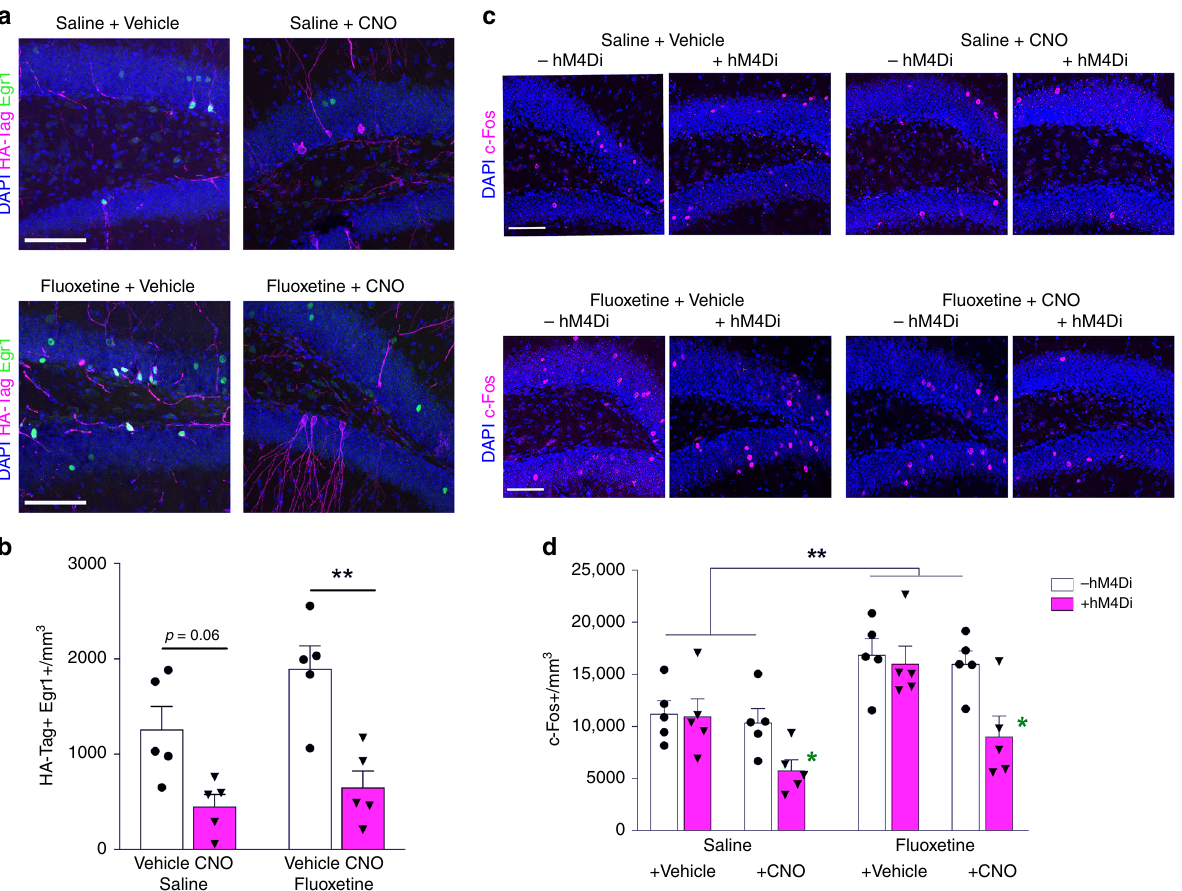
Fig. 3 CNO prevents the fl uoxetine-induced increase in activity of dentate gyrus neurons in vivo. a Representative images of HA-Tag + Egr1 + double- labeled dentate gyrus cells. b Quanti fi cation of HA-Tag + Egr1 + cells in the dentate gyrus (by two-way ANOVA: Fluoxetine F 1,16 = 4.288, P = 0.0549; CNO F 1,16 = 26.16, *** P = 0.0001; Interaction F 1,16 = 1.184, P = 0.293). c Representative images of c-Fos-positive dentate gyrus cells. d Quanti fi cation of c- Fos expression in the dentate gyrus. (by three-way ANOVA: Fluoxetine F 1,32 = 21.55, *** P < 0.0001; hM4Di F 1,32 = 9.01, ** P = 0.005; CNO F 1,32 = 10.85, ** P = 0.002; hM4Di*CNO F 1,32 = 6.14, * P = 0.019; Tukey posthoc test + hM4Di + CNO Saline treatment versus other saline treatment groups * P < 0.05; + hM4Di + CNO Fluoxetine treatment versus other fl uoxetine treatment groups * P < 0.05). Data are presented as means± s.e.m. Scale bars 50 μ